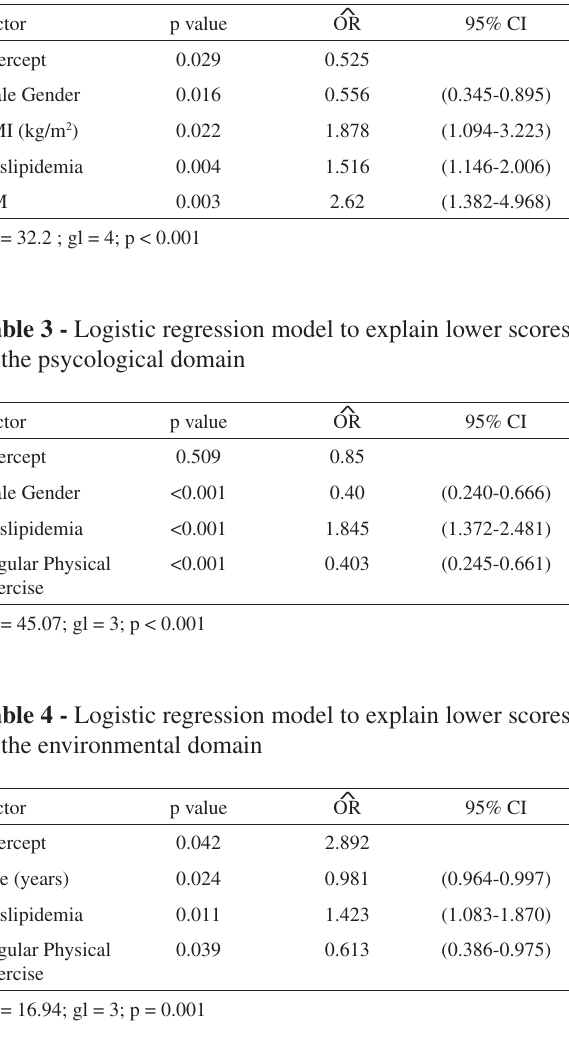
Table 2 - Logistic regression model to explain the